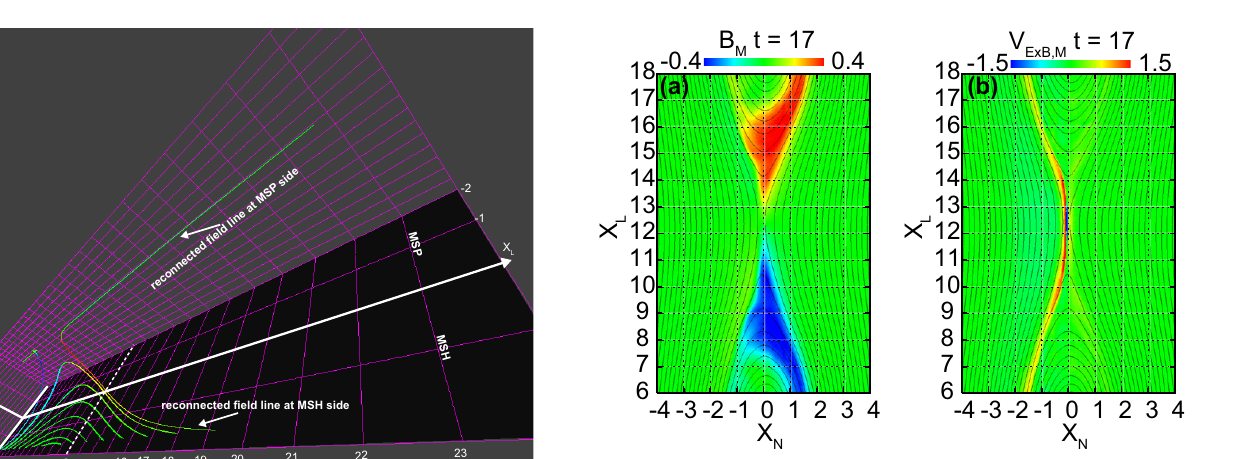
Fig. 7. Three-dimensional structure of the magnetic field lines. Color on the field lines represents B M . Color of red, green, and blue in the field lines are B M > 0, ∼ 0, and < 0, respectively. Focus- ing on a newly reconnected magnetic field, this reconnected field line is strongly lifted up in the positive x M -direction around the X- line on the MSH side where B M > 0 is strongly enhanced. Then, it lies on the x L - x N plane along the MSP SR ( B M ∼ 0). This defor- mation of the field line takes place as the portion of the reconnected field lines along the MSP SR quickly drifts in the +M direction upon crossing the SR.